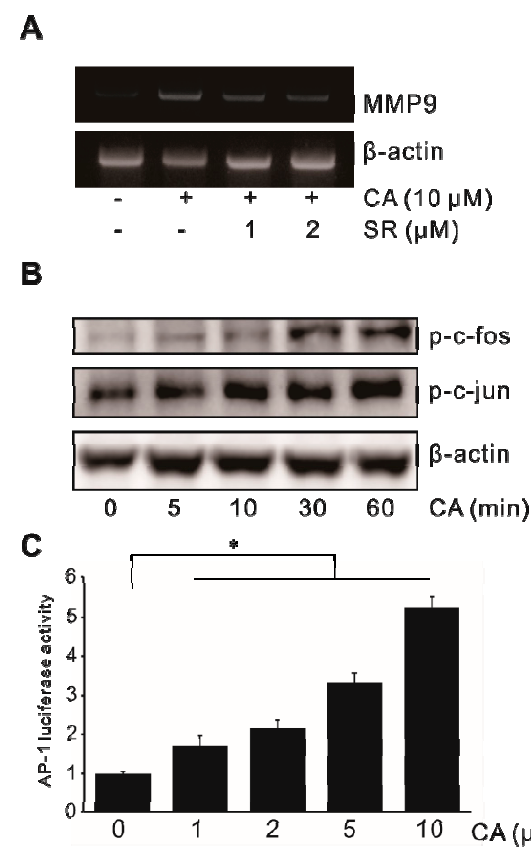
Figure 5. Activation of AP-1 in CA-induced MMP-9 expression in colon cancer cells. ( A ) SW620 cells pretreated with SR-11302 (SR) for 1 h were incubated with 10 µ M CA for 6 h, followed by mRNA extraction and RT-PCR to determine MMP-9 expression level. ( B ) SW620 cells were treated with 10 µ M CA for 0–60 min and cell lysates were analyzed for phosphorylated c-fos and c-jun levels by Western blot analysis. ( C ) SW620 cells were transiently transfected with the AP-1 luciferase reporter construct. Transfected cells were treated with 0–10 µ M CA for 8 h and then luciferase activity was determined using a luminometer. Data represent the mean ± standard deviation (SD) from triplicate measurements. * p < 0.05 versus control.